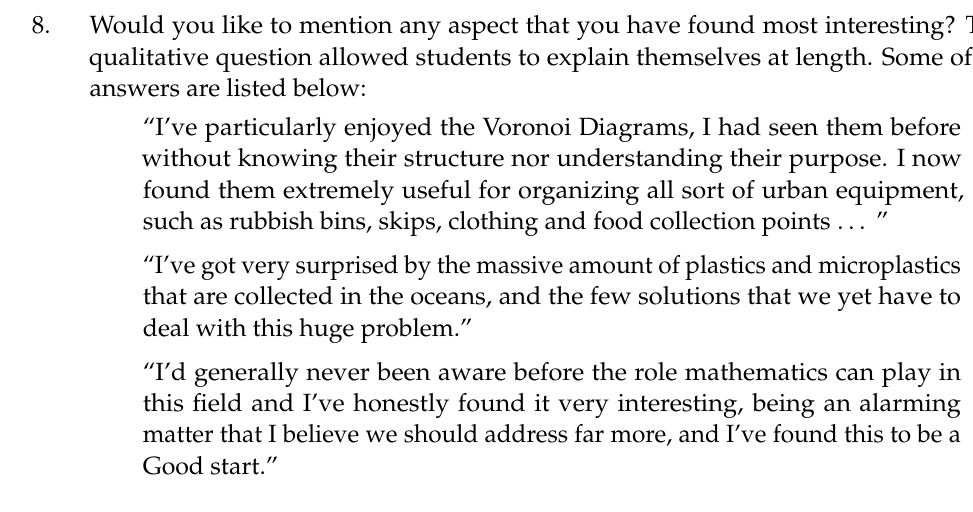
Figure 18. Students interest in these activities.